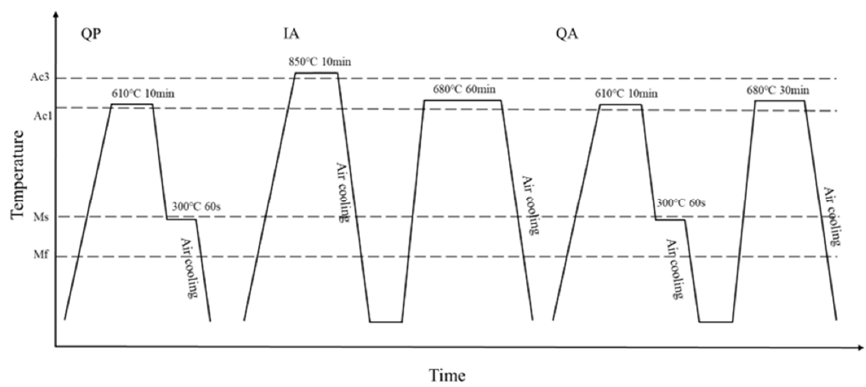
Figure 2. Schematic diagram of QP-300 process, IA-680 process and QA-680 process.